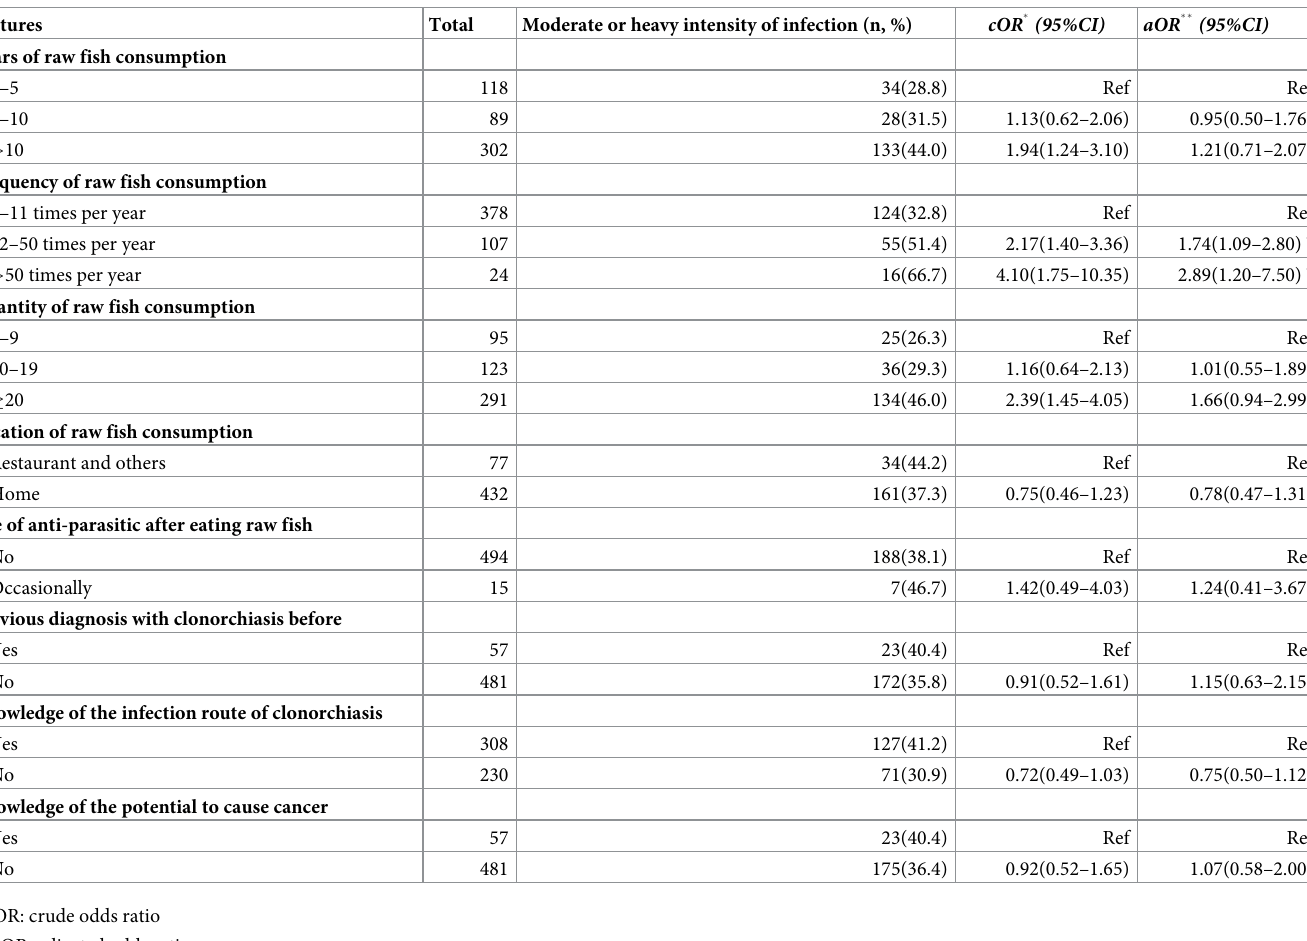
Table 3. Risk Factors of High Infection Intensity (Moderate and Heavy Infections) Based on Multivariate Logistic Regression.